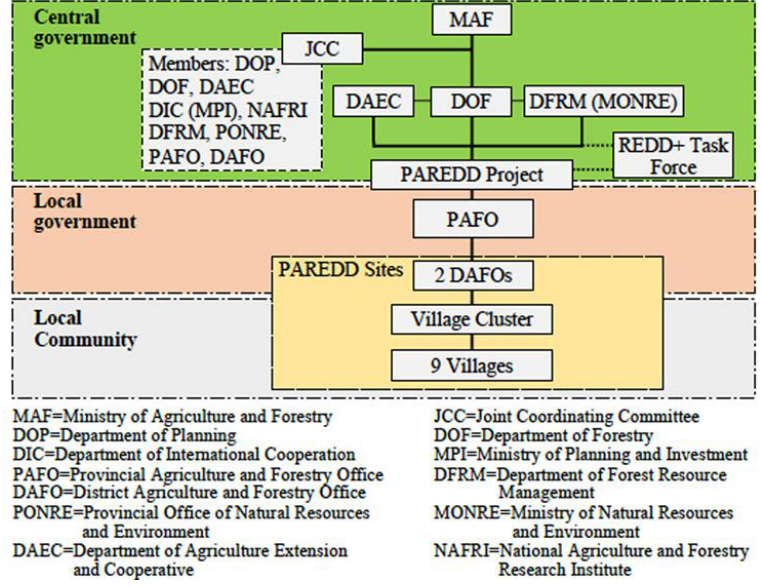
Figure 2. Current institutional structure and implementation agencies of PAREDD. Source: adapted from terminal report [42].